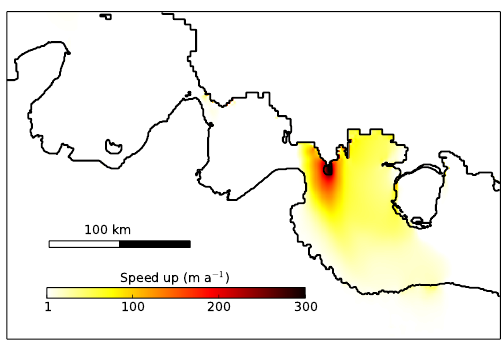
Figure 5. Speed up due to unpinning after 50a for medium melt rates M b1 and linear sliding. Absolute velocity differences (ma − 1 ) between B e /U/L/M b1 /A m and B u /U/L/M b1 /A m